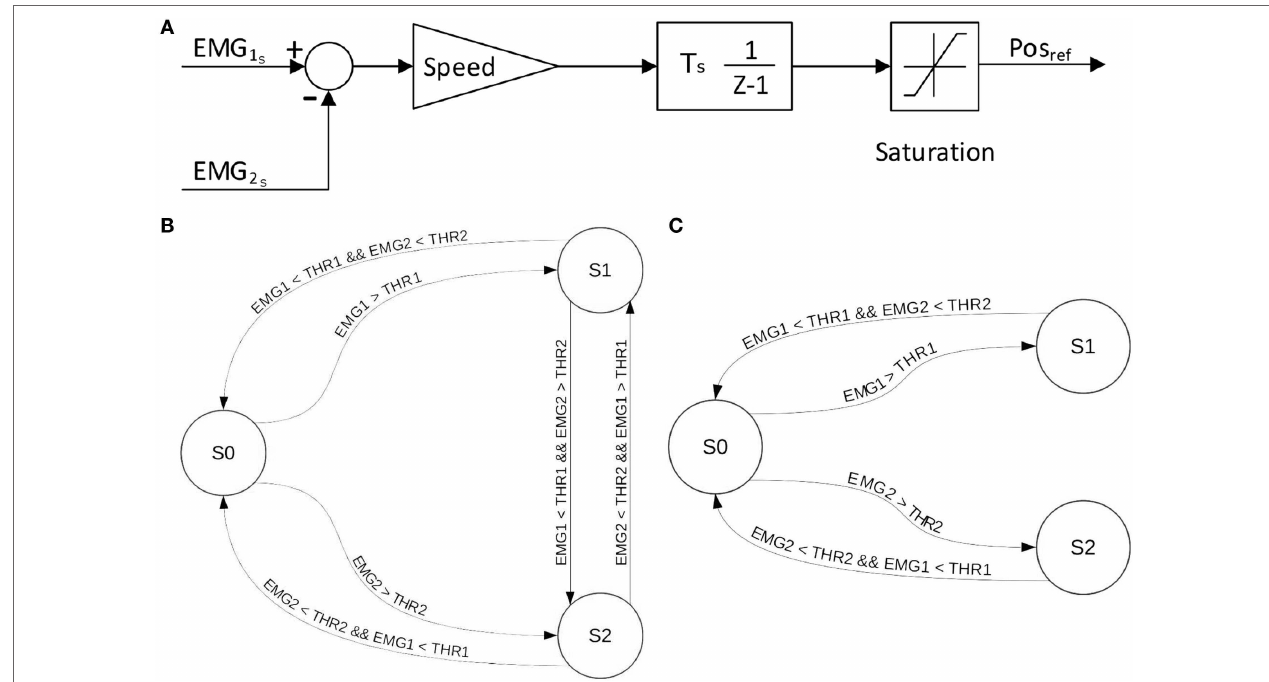
FIGURE 3 | EMG-to-position algorithms implemented on the SH-P . EMG-differential (A) , EMG-FCFS (B) , and EMG-FCFS-Advanced (C) . EMG1 and EMG2 denote the two signals acquired from the agonist–antagonist muscle pair. THR1 and THR2 denote the threshold for EMG1 and EMG2, respectively. S0, S1, and S2 denote the steady position, closing movement, and opening movement,